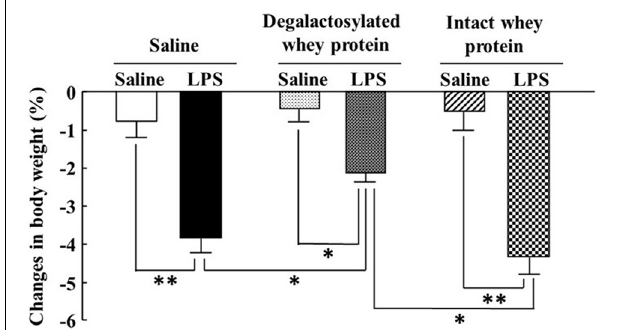
FIGURE 3 | Effects of intraperitoneal administration of degalactosylated whey protein for 5 days on body weight loss induced by intraperitoneal administration of LPS in mice. Body weight changes (%) in mice at 4 h after intraperitoneal administration of LPS (0.33 mg/kg) following intraperitoneal administration of intact and degalactosylated whey proteins (10 mg/kg) for 5 days. Results are expressed as mean ± SE for 8–12 mice. ∗ p < 0.05, ∗∗ p <